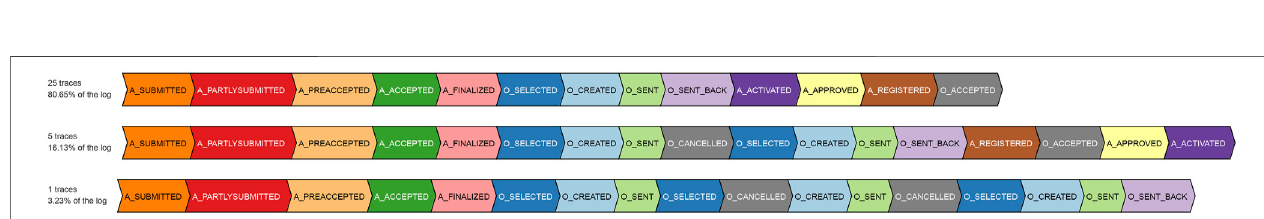
FIGURE 10 | Example cases with different noise types in the application process and offer sub-process of the BPIC ’ 12 event data.